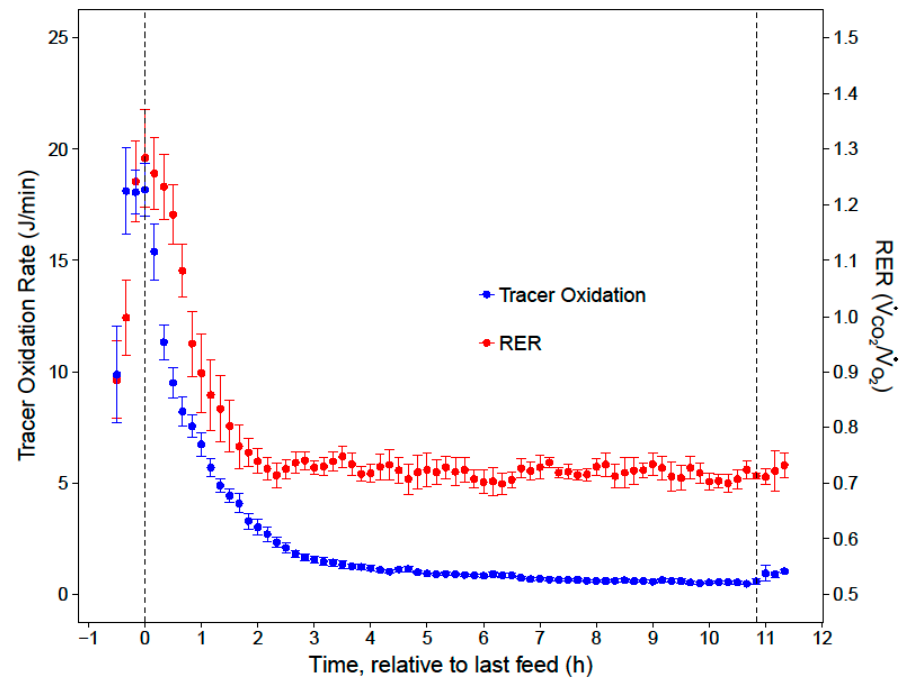
Figure 3. Average overnight instantaneous 13 C tracer oxidation rates (J/min; blue), and RER (red) exhibited by ruby-throated hummingbirds in fed trials. Time is relative to the time of the last feeding (time = 0), which was, on average, 10 min prior to lights out. Vertical dashed lines indicate time of lights off and on. Data are presented as mean ± SEM of 10-min bins averaged across the individual birds (n = 6).